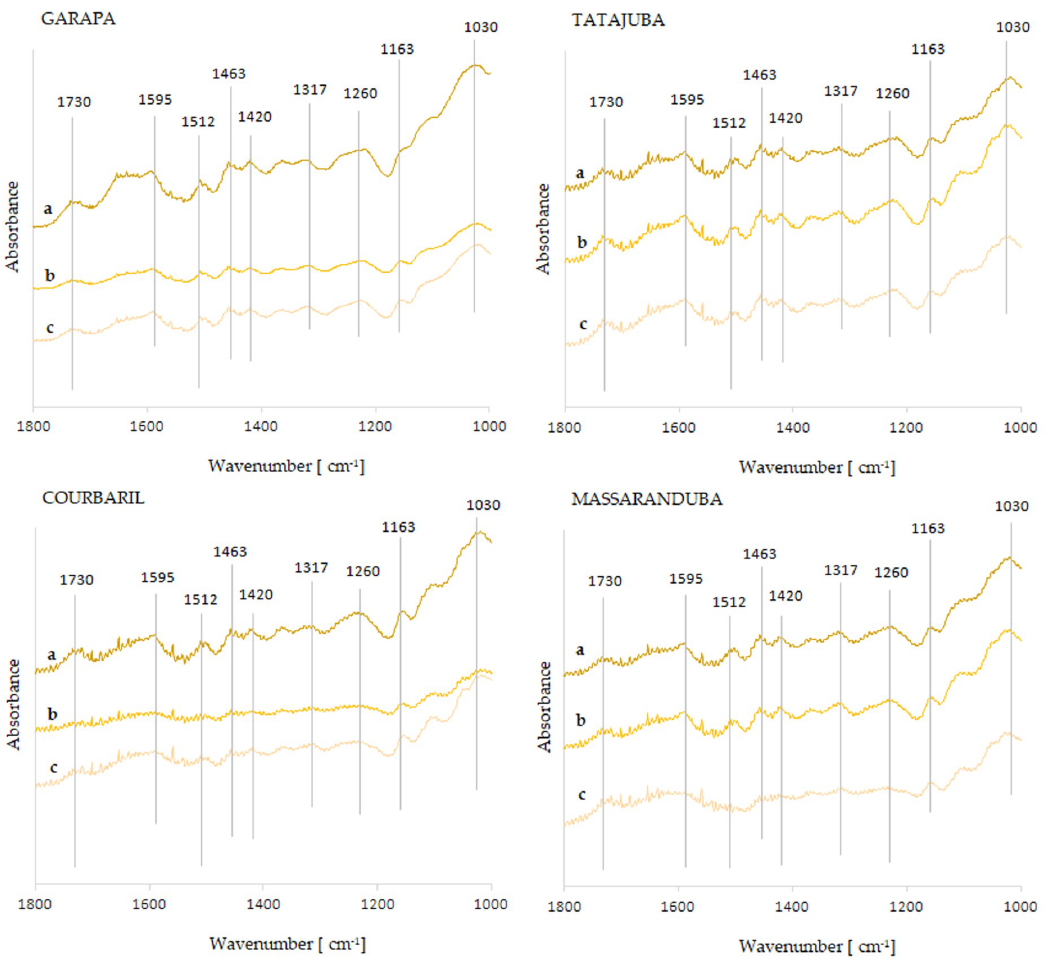
Figure 5. FTIR spectra of tested wood species before, after UV irradiation and after four full artificial weathering cycles: a —fresh wood, b —after UV irradiation, c —after four artificial weathering